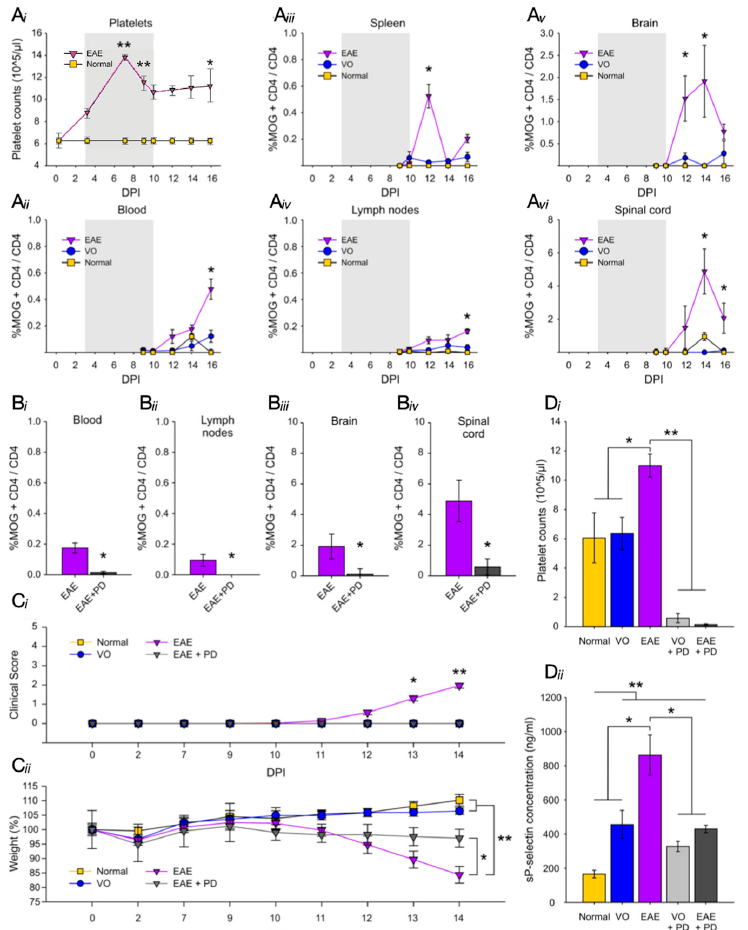
Figure 1. The relationship between platelet accumulation, MOG 35–55 -CD4 + cell accumulation and EAE development. ( A ) Platelet counts were performed over the disease course in normal (yellow) and EAE-induced mice (purple) using an automated hematology analyzer and data expressed as platelets numbers/L. ( Ai ) shows significant (** = p <0.01) elevation by 7 dpi, and significantly (* = p <0.05) elevated numbers until 16 dpi. Antigen-specific T cell accumulation was estimated by ICS over the same time course and expressed as % MOG 35–55 -CD4 + over total CD4 + cells. Comparison between ( Ai ) and ( Aii – Avi ) shows a distinct delay between the peak of platelet accumulation in the circulation (shaded area) and that of MOG 35–55 -CD4 + cells in blood ( Aii ), secondary lymphoid organs (spleen: Aiii and lymph nodes: Aiv ) and CNS tissues (brain: Av and spinal cord: Avi ). EAE = EAE-induced (purple), VO = vehicle-only (blue) and N = normal (yellow) mice. In both experiments, n = 6/group/time point. ( B) shows inhibition of MOG 35–55 -CD4 + cell accumulation by platelet depletion in blood ( Bi ), lymph nodes ( Bii ), brain ( Biii ) and spinal cord ( Biv ). Depletion was initiated at 7 dpi and ICS performed at 14 dpi, with n = 6/group. ( Ci) shows the effect of platelet depletion on disease course, with only EAE-induced/isotype antibody-treated group (purple) exhibiting significantly different clinical scores and weight loss, relative to normal (yellow), VO/PD (blue) and EAE/PD-treated (black) groups. The EAE-induced/isotype antibody-treated group exhibited significant weight loss relative to normal and vehicle only groups and significant weight loss relative to the EAE-induced/PD-treated group ( Cii ). ( Di) shows confirmation of platelet depletion with anti-CD42b and ( Dii ), estimation of sP-selection by ELISA, showing significantly elevated levels of this component in VO mice, significantly levels in EAE mice and restoration to VO levels by platelet depletion. Experiments B to D were performed on the same groups of mice. EAE = experimental autoimmune encephalomyelitis, ICS = intracellular cytokine staining, VO = vehicle-only, PD = platelet depletion, CNS = central nervous system, ELISA = enzyme-linked immunosorbent